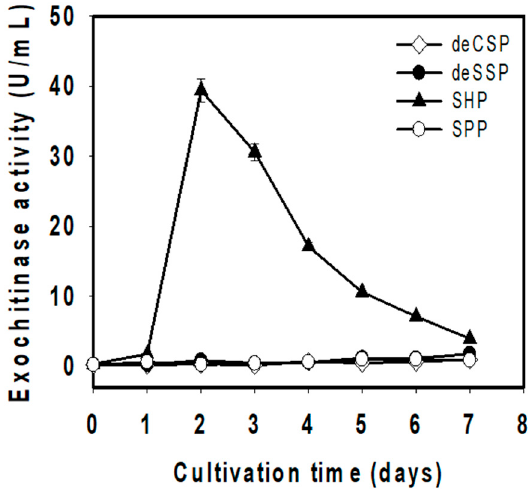
Figure 1. Effect of different chitinous byproducts on S. speibonae TKU048 exochitinase production. The medium was prepared by adding 1 g of each different fishery byproducts, including demineralized crab shell powder (deCSP), demineralized shrimp shell powder (deSSP), shrimp head powder (SHP), and squid pen powder (SPP) to 250 mL glass Erlenmeyer flasks containing 100 mL of basal salt medium. The cultivation conditions were conducted with 1% ( v / v ) of stock solution of S . speibonae TKU048, at an incubation temperature of 37 °C, and 150 rpm of agitation. An aliquot of culture (1 mL) was withdrawn every 24 h for testing exochitinase activity.